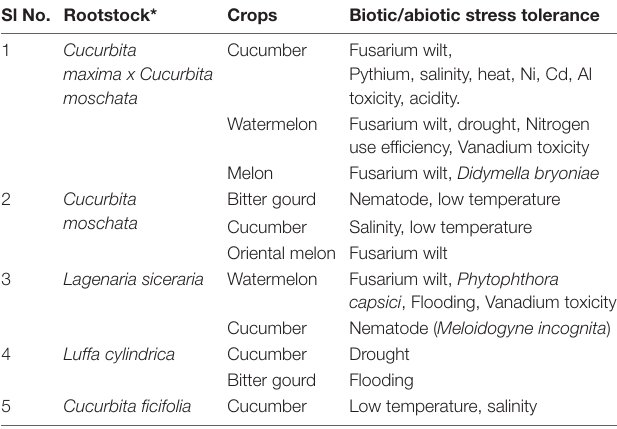
TABLE 7 | Prospective rootstocks for multiple stresses tolerance interventions. TABLE 8 | Biotic stress resistant genotypes identified cross different